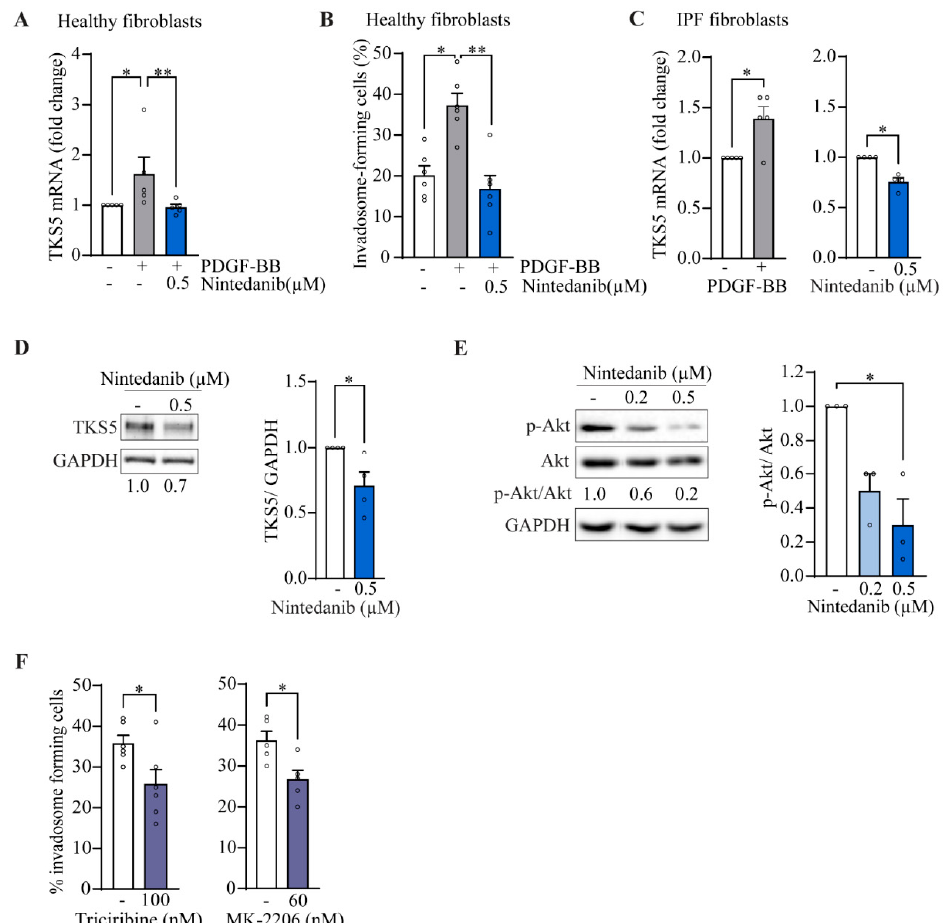
Figure 5. Nintedanib inhibits p -Akt and TKS5 in IPF fibroblasts. Healthy lung fibroblasts were cultured in the presence of PDGF-BB 25 ng/mL +/ − nintedanib. ( A ) The mRNA levels of TKS5 ( n = 5) and ( B ) the percentage of invadosome-forming cells ( n = 6) were measured. IPF fibroblasts were cultured in the presence of PDGF-BB 12.5 ng/mL or nintedanib 0.2 µM and 0.5 µM. ( C ) mRNA levels of TKS5 were determined ( n = 4 − 5) and expressed in folds relative to untreated cells. Immunoblot of ( D ) TKS5 and ( E ) phosphorylated Akt (S473) with corresponding densitometric analysis relative to untreated ( n = 4). ( F ) The percentage of invadosome-forming cells in IPF fibroblasts treated with the Akt inhibitors triciribine ( n = 6) and MK-2206 ( n = 5). * p < 0.05, ** p <